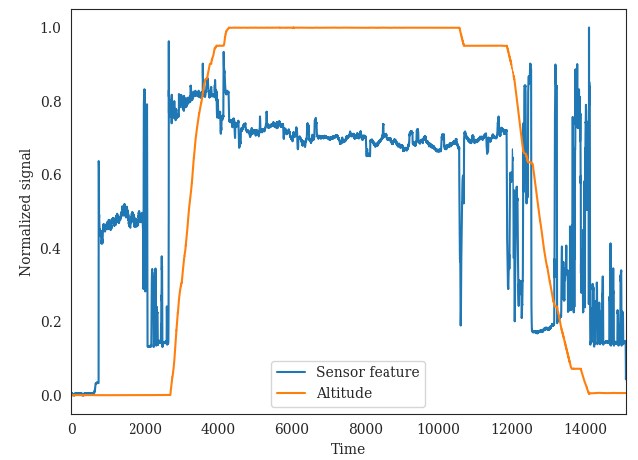
Figure 5. The influence of the different flight phases on the condition monitoring signals. The plot shows the normalized signals of altitude and health monitoring feature for a randomly selected